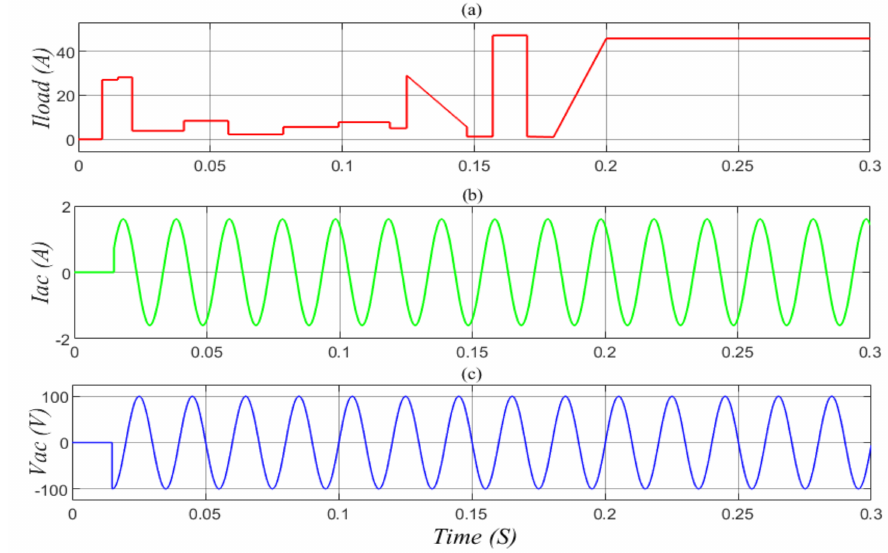
Figure 9. Current load, AC load output under load and radiation changes. ( a ) The load current curve. ( b , c ) AC load